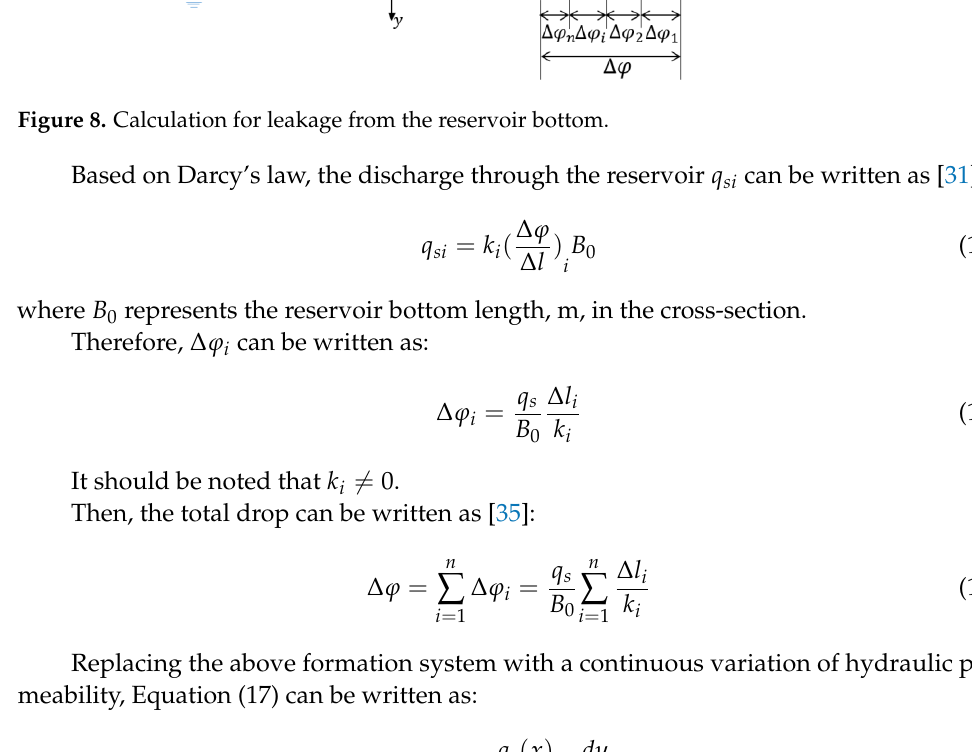
Figure 7. Groundwater level close to earth surface.